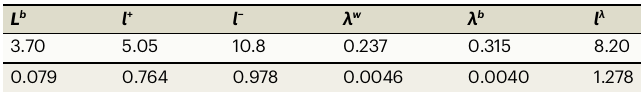
Table 1 | Fit parameters ( μ m) for Eqs. (6), (7) and (8) and their standard error L b